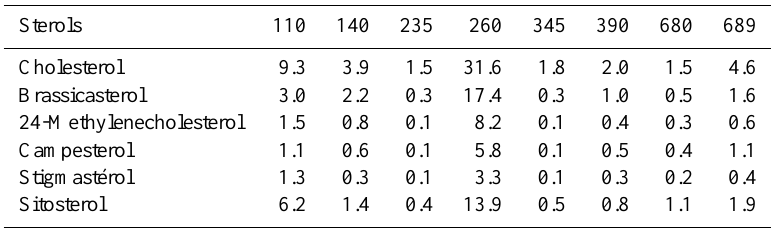
Table 1. Sterols content (µg g − 1 ) of the sediments investigated.